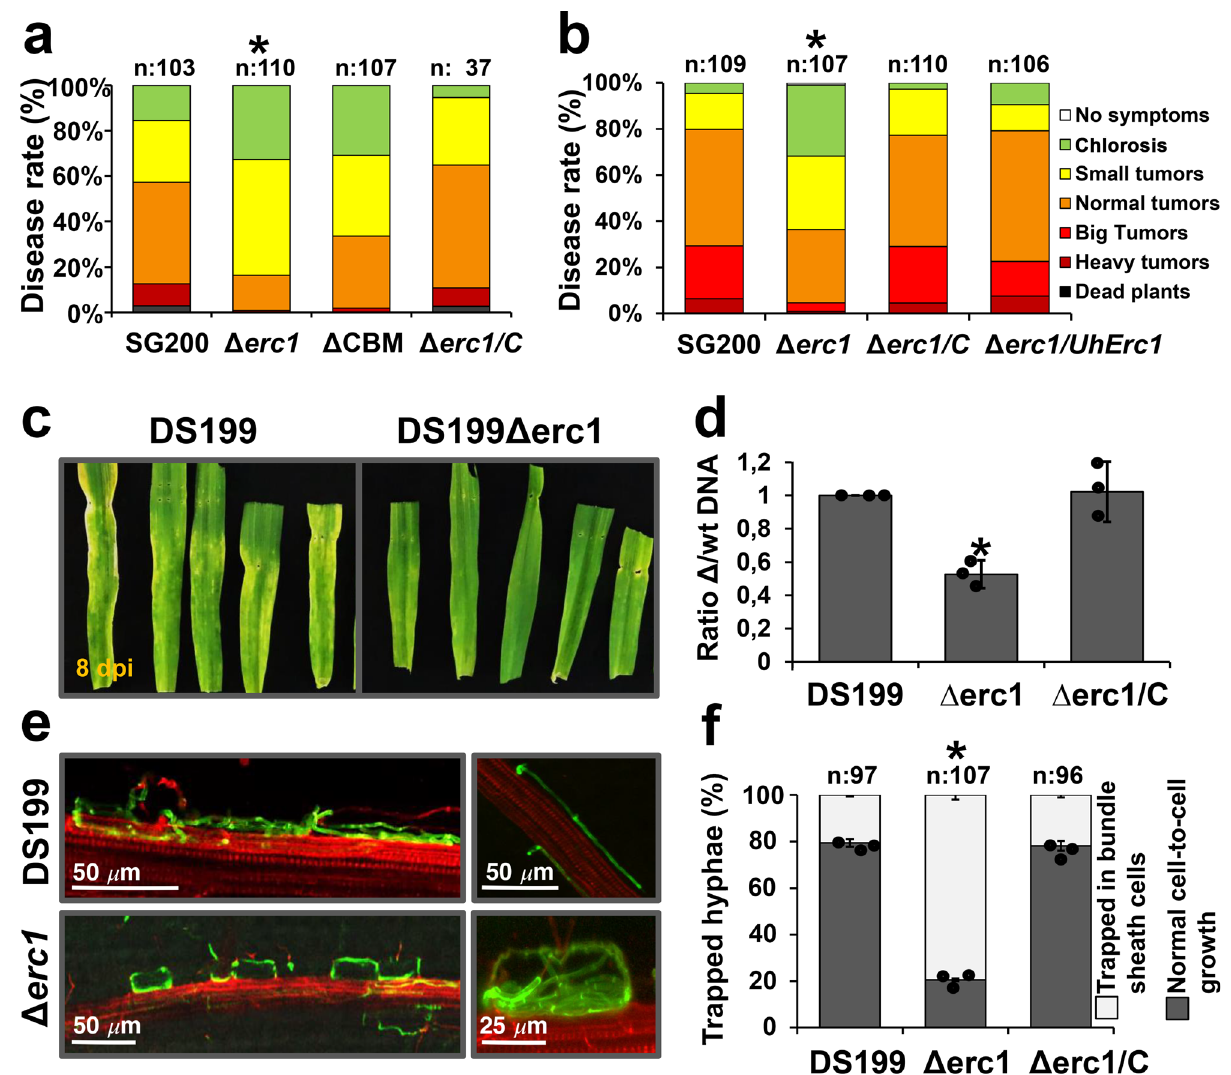
Fig. 2 | Erc1 is functionally conservedin smut fungi. a The carbohydrate-binding module (CBM) is required for full function of Ustilago maydis Erc1. Disease assay was performed for U. maydis SG200, SG200 Δ erc1, SG200 Δ erc1/C strain, and SG200 Δ erc1/Erc1 Δ CBM on EGB maize at 12 days post inoculation (dpi). Disease rates are given as a percentage of the total number of infected plants. n : indicates total number of infected maize seedlings in three independent biological experi- ments. Asterisks above bars indicate signi fi cant differences ( p <0.05, two-tailed student ’ s t-test). b Complementation of SG200 Δ erc1 mutant with Ustilago